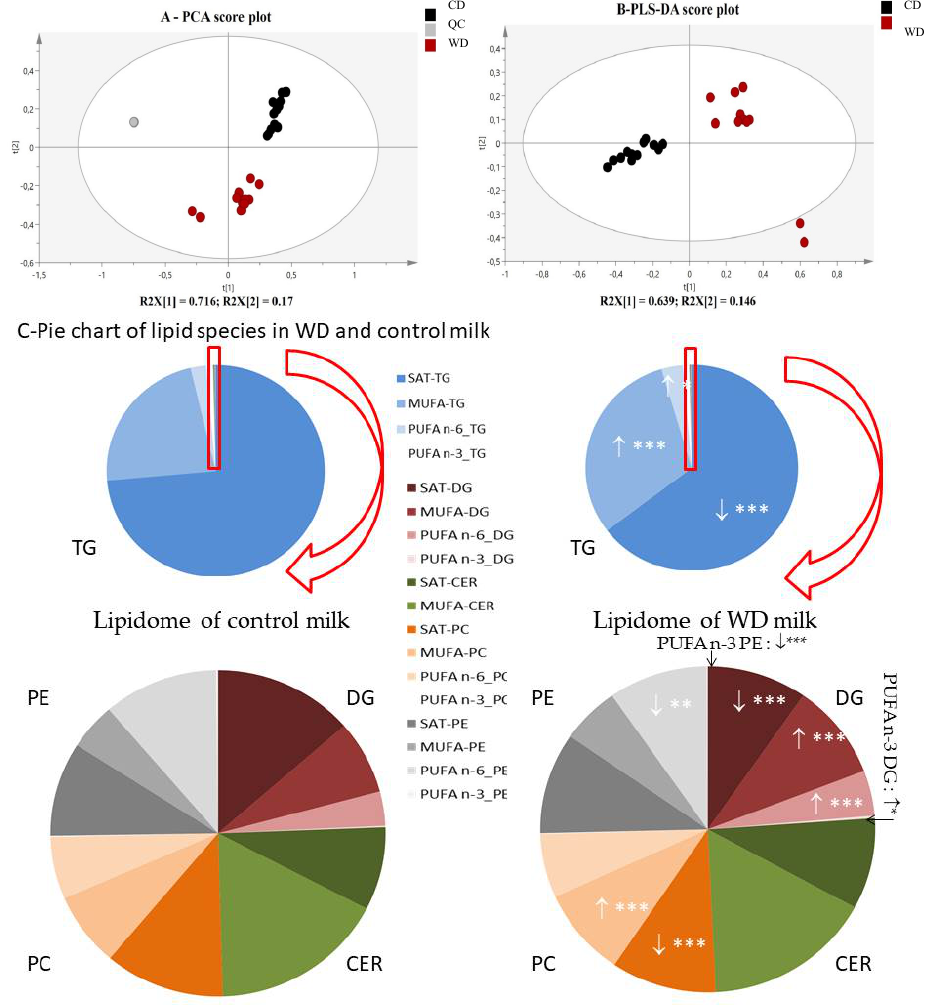
Figure 5. ( A ) PCA analysis reveals an influence of maternal high caloric diet during gestation and lactation on milk lipidome. PCA score plot on the two